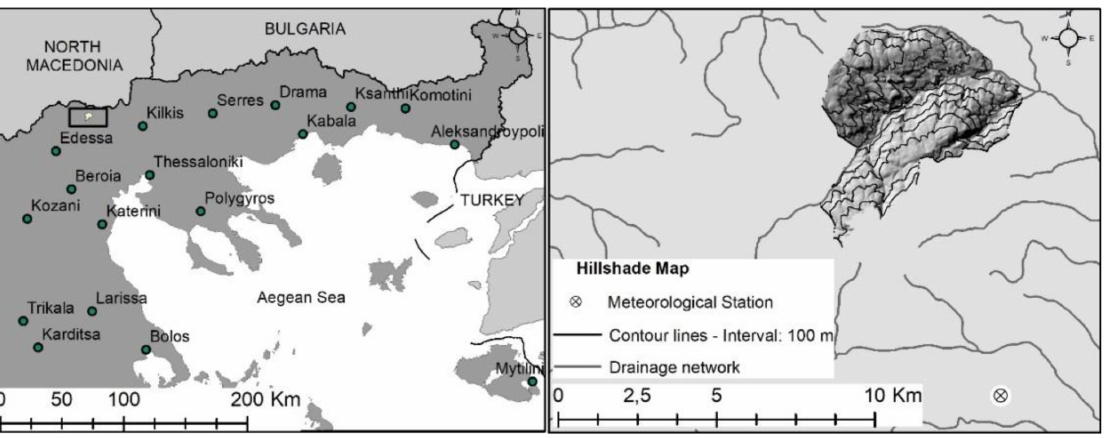
Figure 1. Location map of the case study